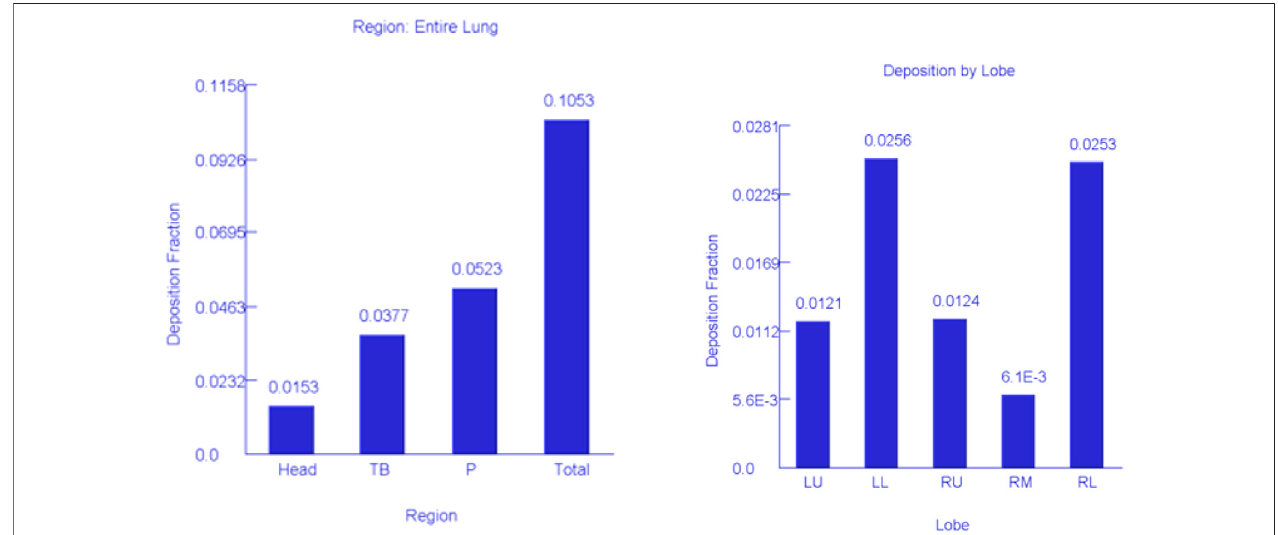
FIGURE 6 | Simulation of lung deposition for the entire lung and lobes. Head, head region; TB, tracheobronchial region; P, pulmonary region; LU, left upper lobe; LL, left lower lobe; RU, right upper lobe; RM, right middle lobe; RL, right lower